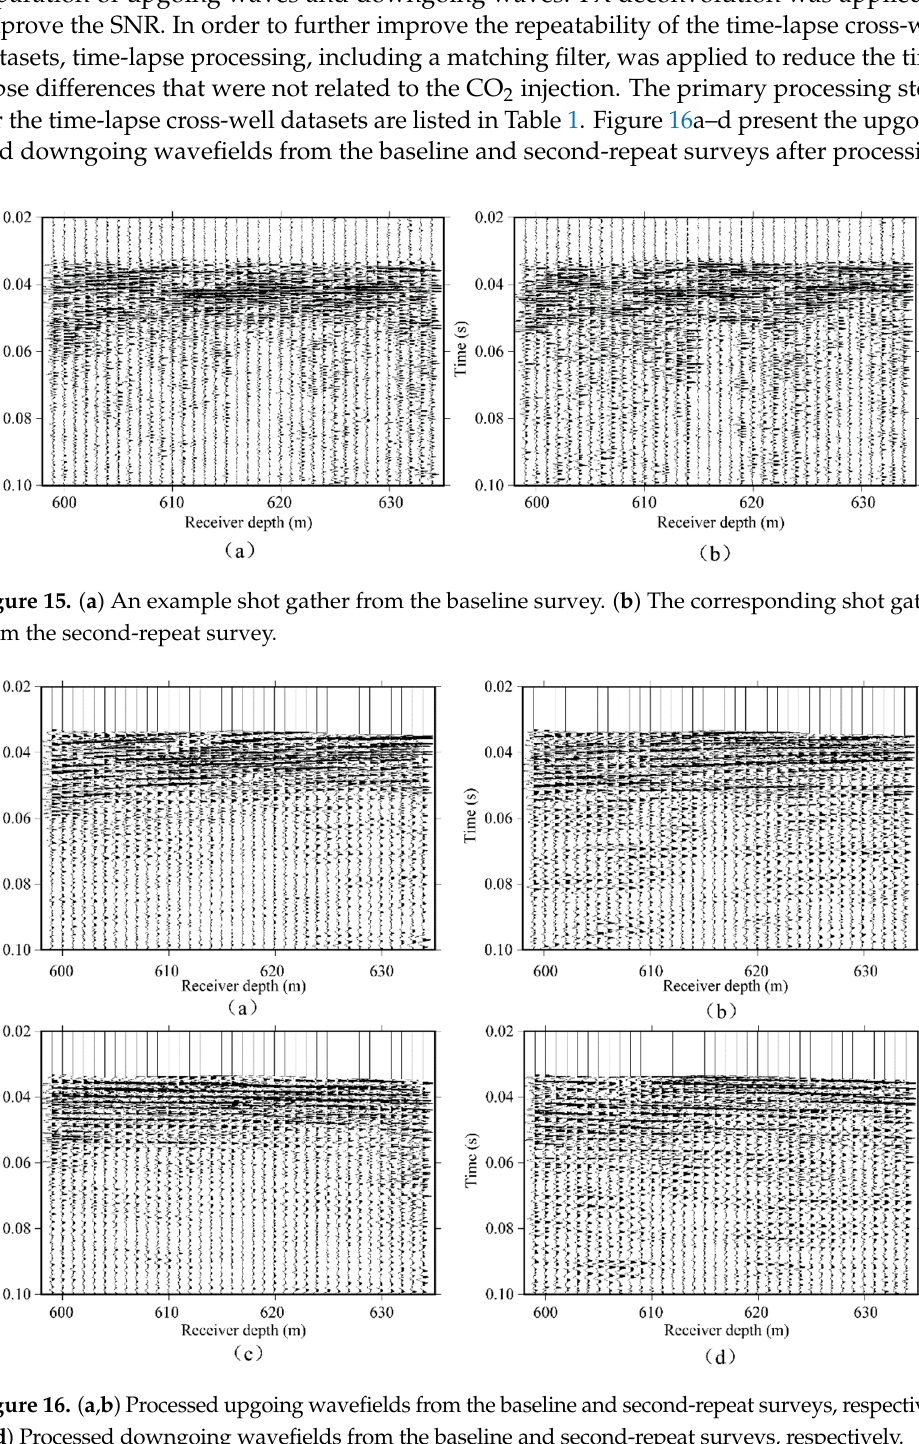
Figure 16. ( a , b ) Processed upgoing wavefields from the baseline and second-repeat surveys, respec- tively. ( c , d ) Processed downgoing wavefields from the baseline and second-repeat surveys, respec-